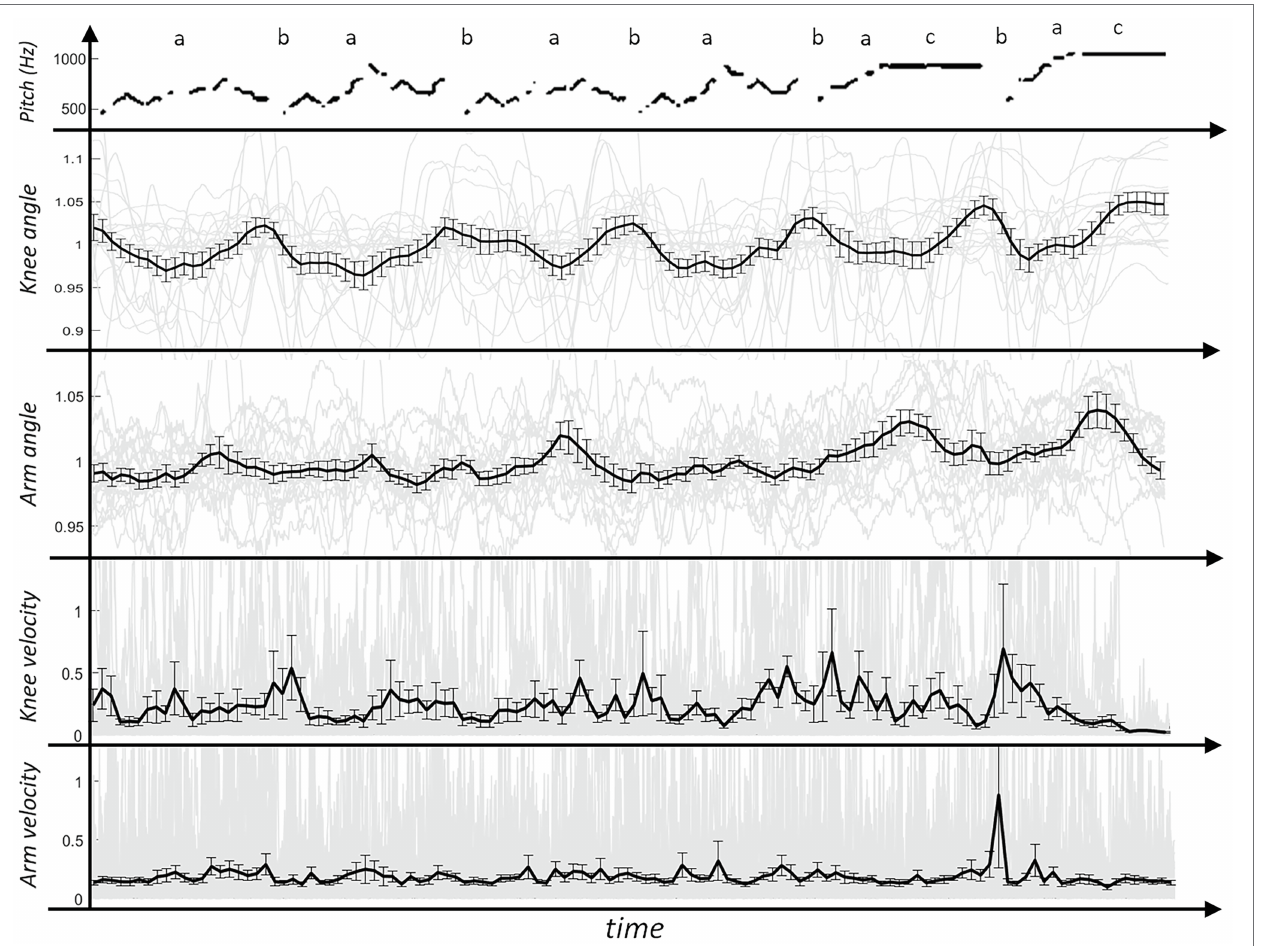
FIGURE 2 | Graphs of the visual movements of the knees and the arms (top row: schematic of the pitch; second and third row: normalized motion of the angle; fourth and fifth row: velocities in 1/50s; gray lines: individual values of the players; thick black line: mean value across all players; error bar: standard error of the